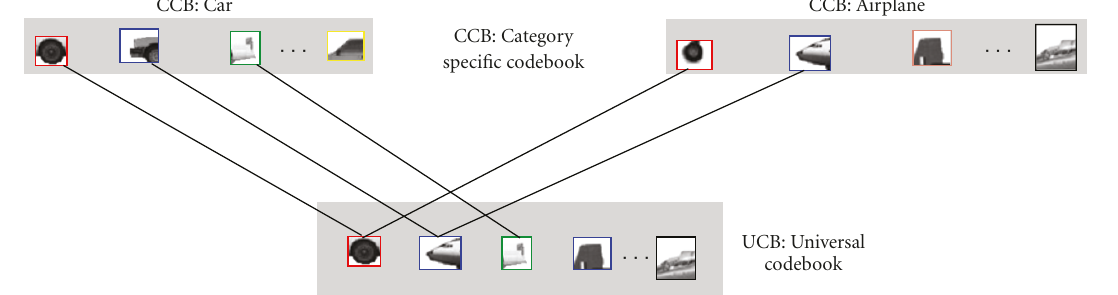
Figure 20: Learning universal codebook from category-specific codebooks.